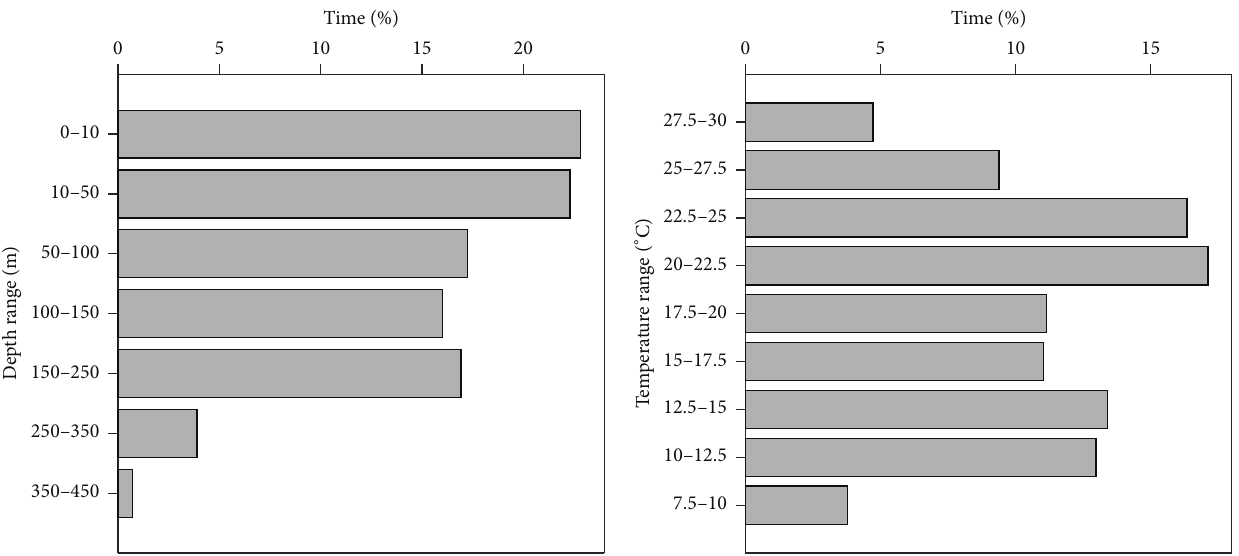
Figure 5: Summaries of depth and temperature range occupation based on all 2004 data from Fish A and Fish B.